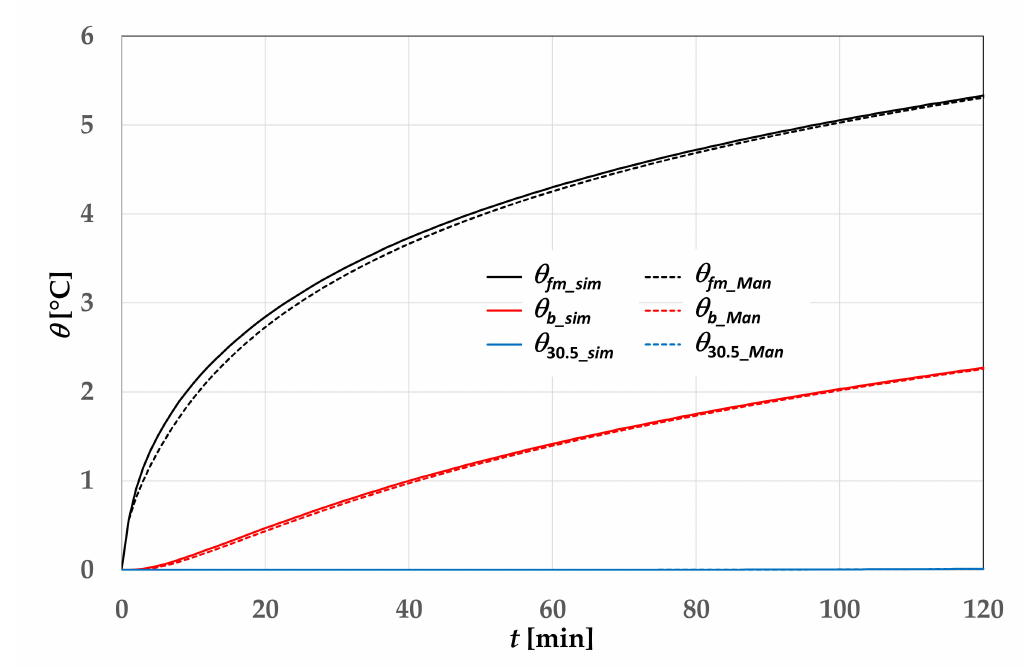
Figure 15. Particular of Figure 14, in the time interval from 0 to 120